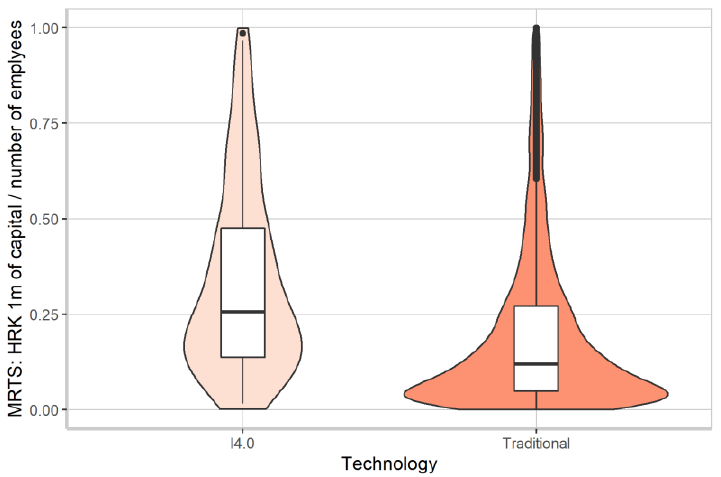
Figure 8. Distribution of the marginal rate of technical substitution (MRTS). Table 5. ANOVA of the marginal rate of technical substitution.